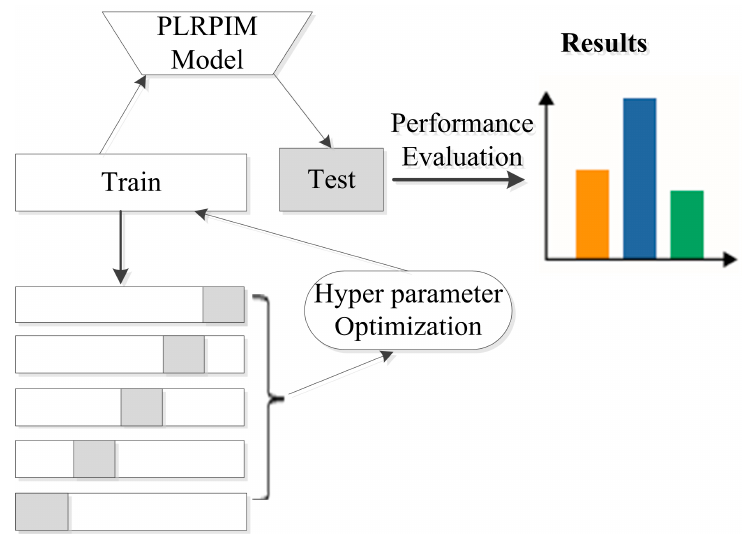
Figure 3. Experimental setup for testing the proposed method. The datasets are split into five folds and hyper parameters are tuned in the training set. The model is learned and applied on the test set based on the hyper parameters. Performance metrics are calculated for all folds.